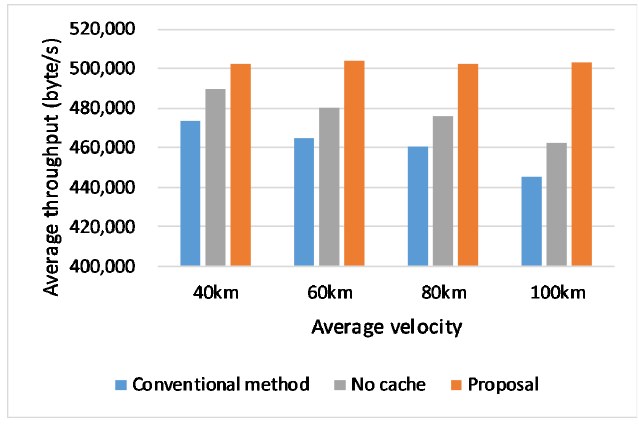
Figure 9. Throughput in different velocities.